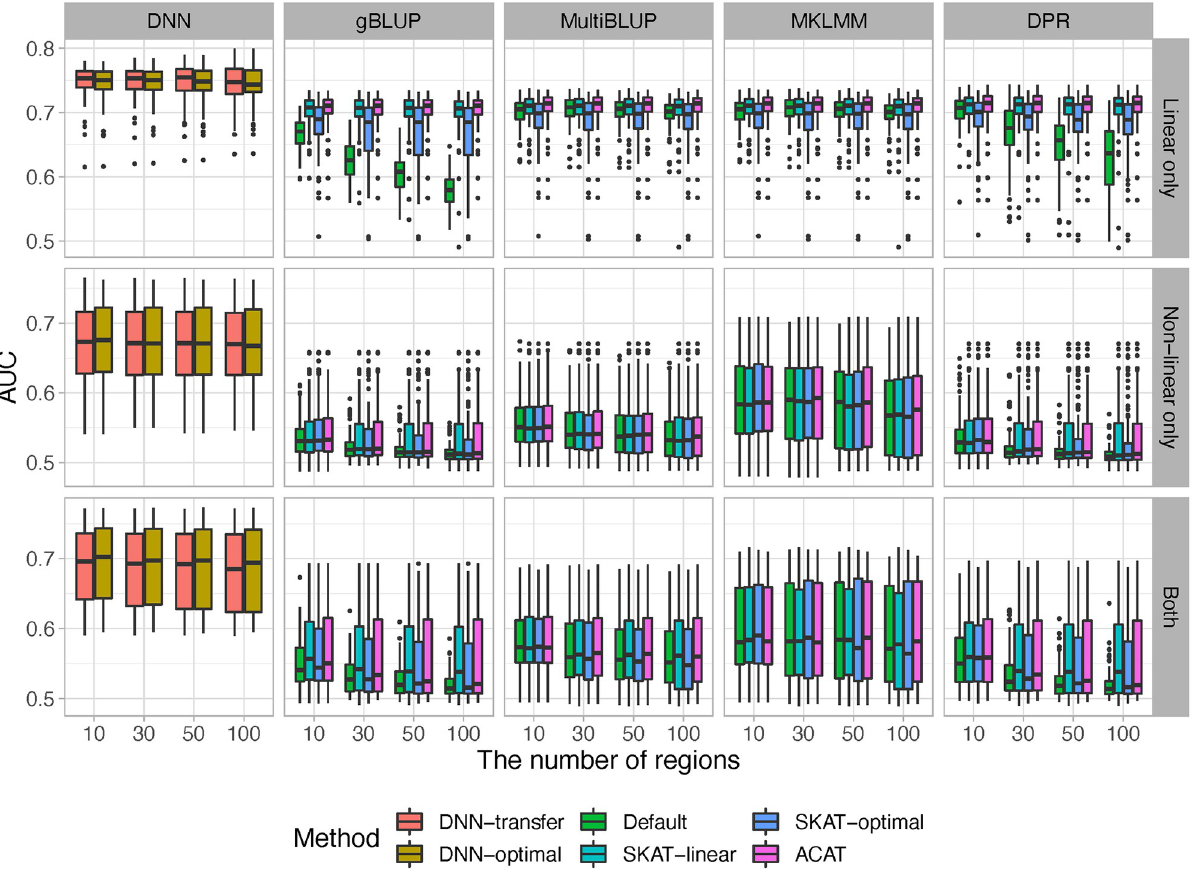
Fig 5. The comparisons of prediction accuracy for binary outcomes. Genes with p-values less than 0.001 are considered significant.